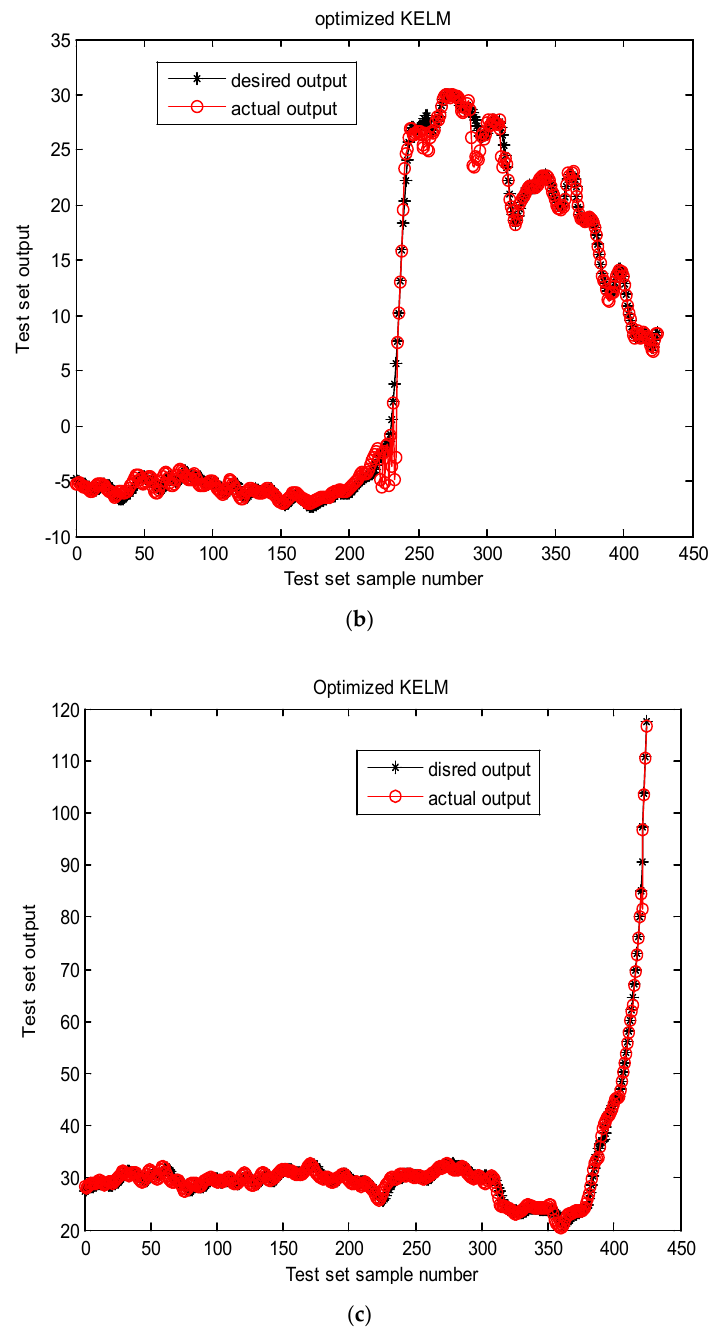
Figure 9. Actual outputs and prediction outputs in working condition 3. ( a ) Phase space; ( b ) wavelet packet space; ( c ) EEMD space.